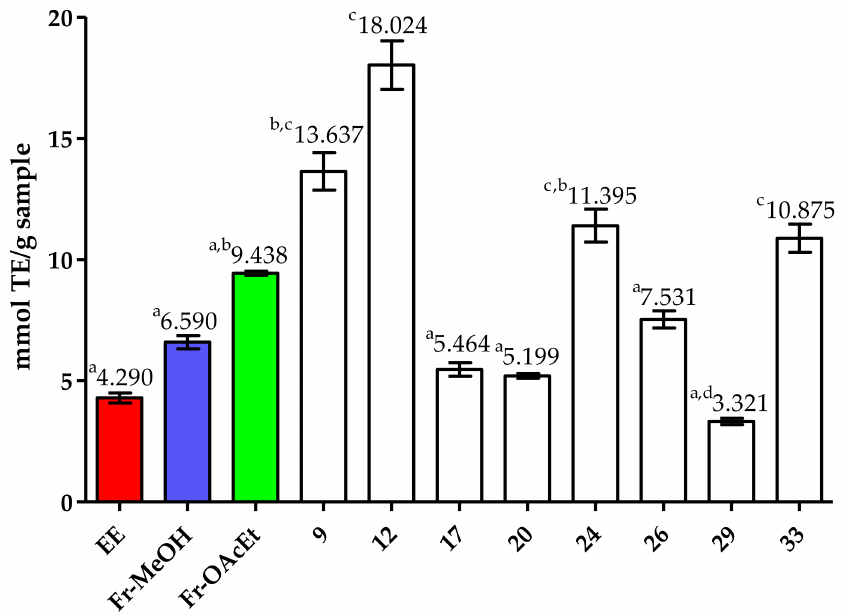
Figure 2. Oxygen radical absorbance capacity comparison for the ethanolic extract (EE), Fr-MeOH, Fr-OAcEt and the 8 isolated compounds from the leaves of Chamaecrista diphylla . The Kruskal–Wallis non-parametric test (equivalent to ANOVA) and Dunn’s post-test were applied [60]. The tests were based on the statistical requisites available in the literature [61] performed in the software R v. 4.03. Different letters refer to significant differences between the eleven samples (EE, Fr-MeOH, Fr-OAcEt, 9, 12, 17, 20, 24, 26, 29, and 33) at a level of p <